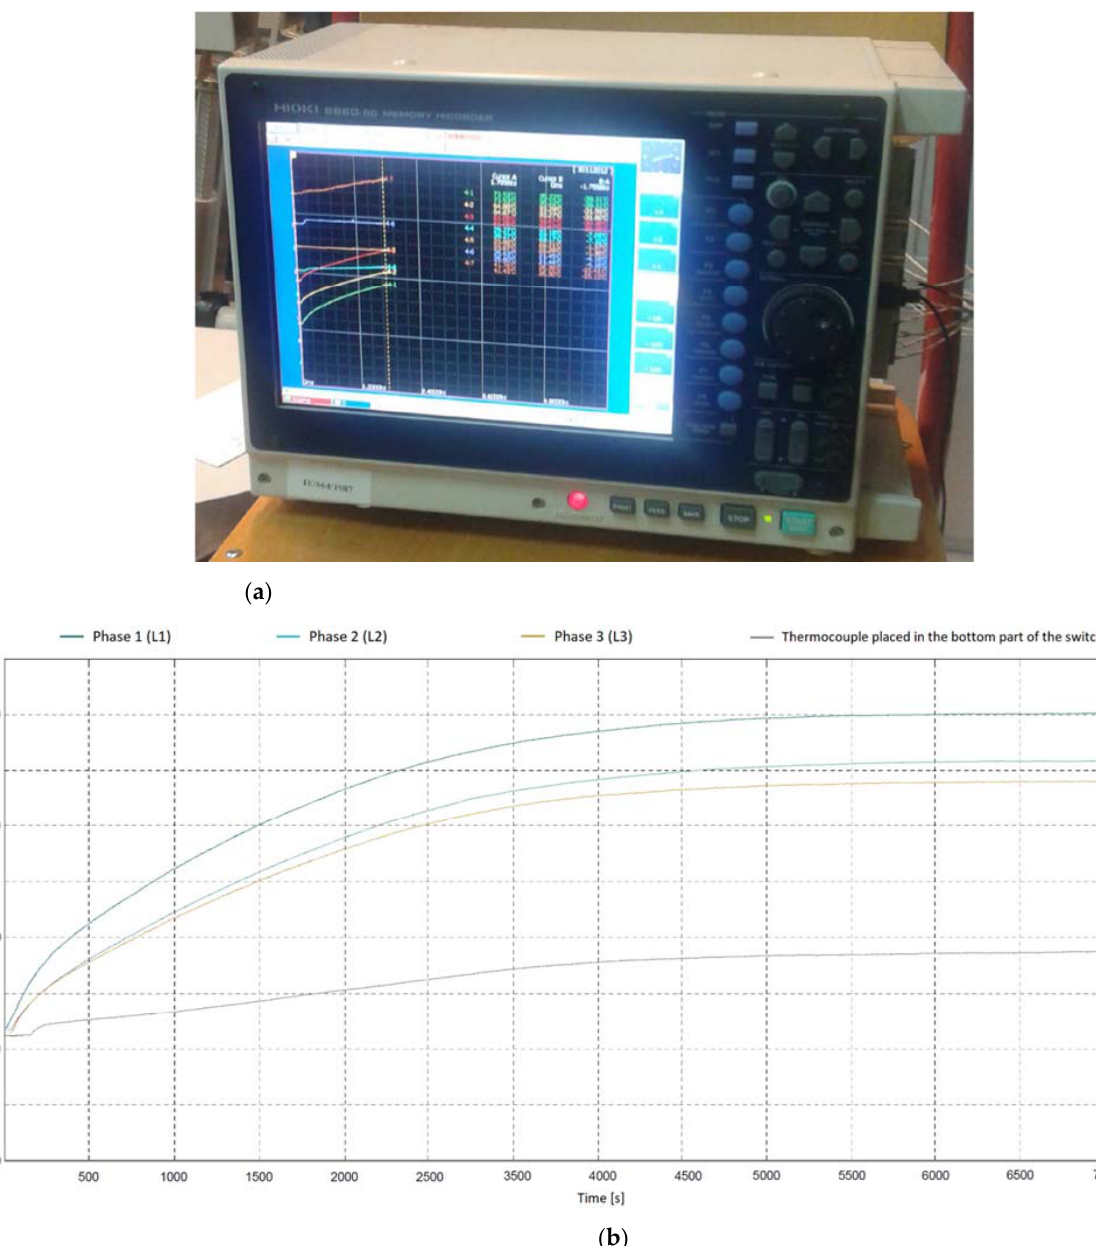
Figure 15. Experimental results: ( a ) measurement results; ( b ) measurement results for phase currents of approximately 630 A.